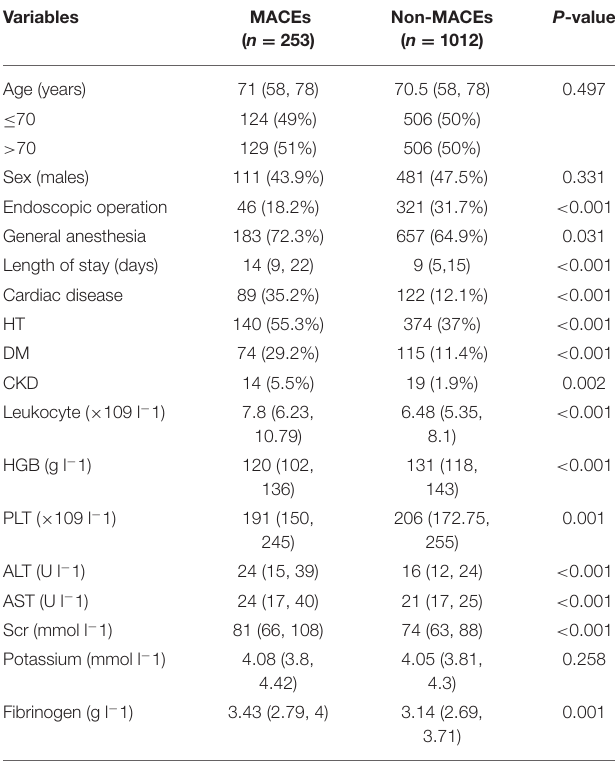
TABLE 1 | Baseline characteristics of the training set.